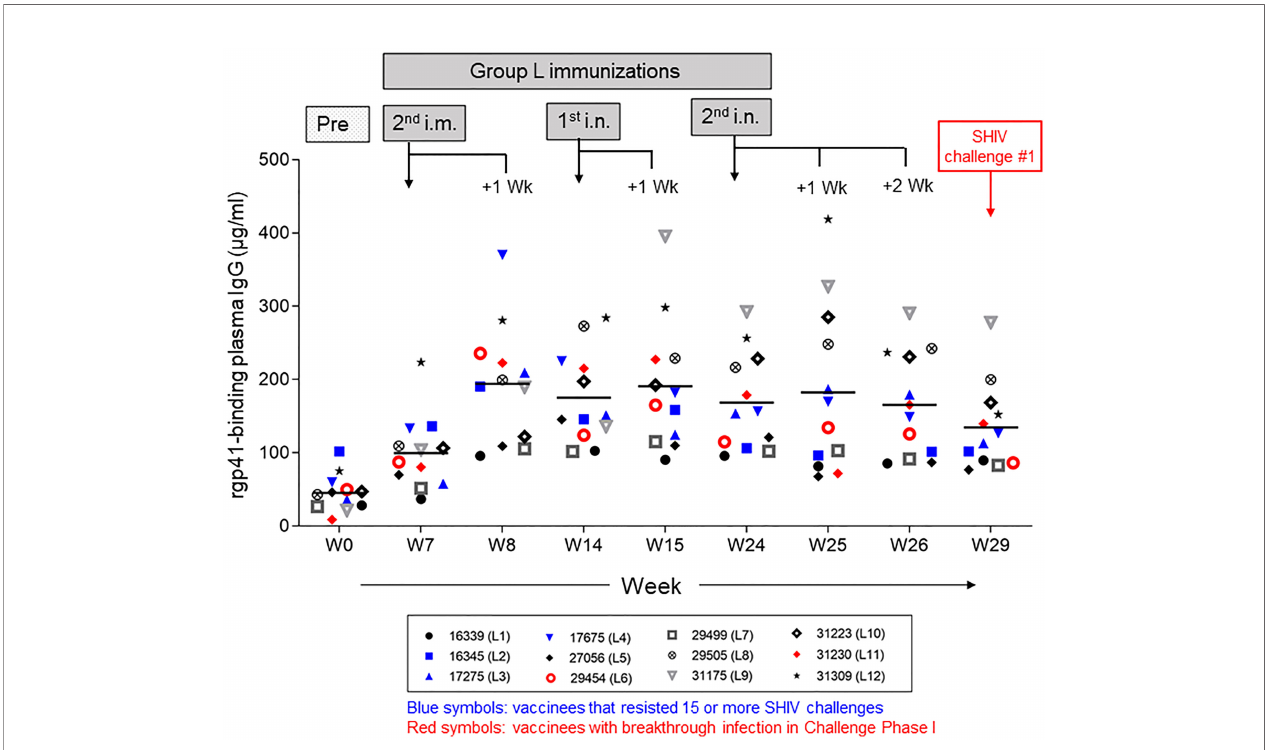
FIGURE 7 | Vaccine-induced anti-HIV-1 gp41 plasma IgG responses in Group L measured by ELISA with rgp41. The timeline for the intramuscular (i.m.) and intranasal (i.n.) immunizations is given in Figure 3 . Plasma samples collected at the time points indicated were assessed for each individual vaccinee in Group L. Data for the two animals with early breakthrough infection during Challenge Phase I are indicated in red symbols; data for vaccinees that remained aviremic during the fi rst 15 challenges or longer are indicated in blue symbols. No clear pattern emerged for either subset of vaccine